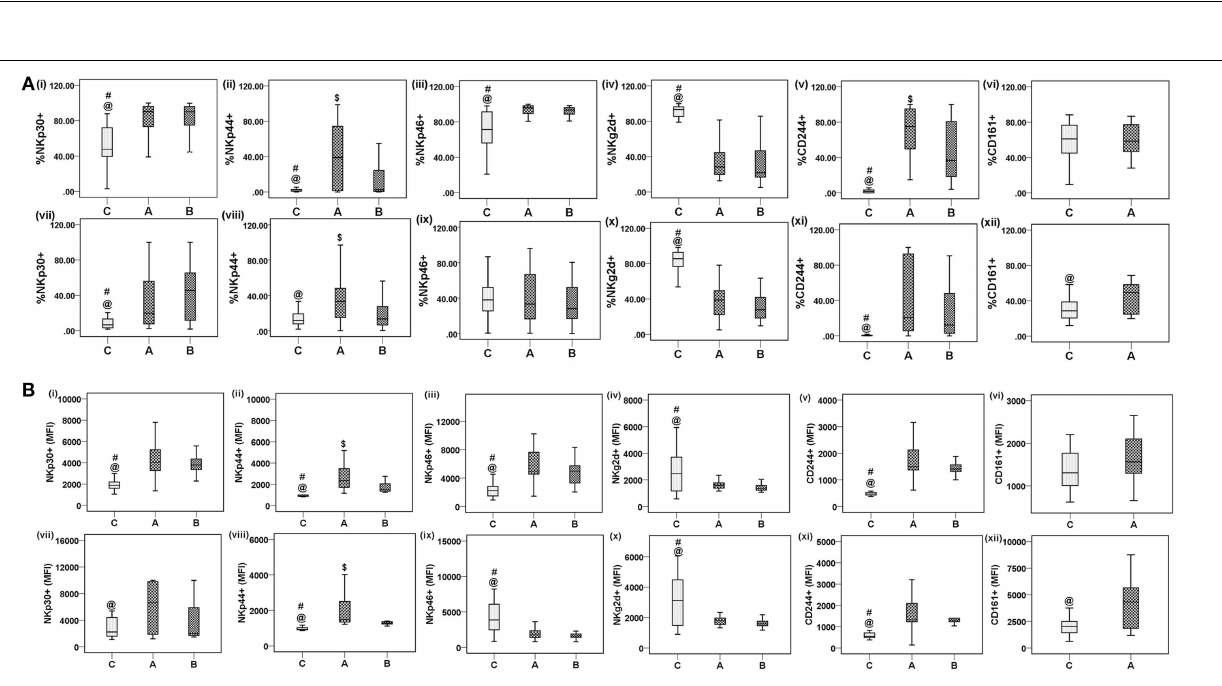
Frontiers in Microbiology |